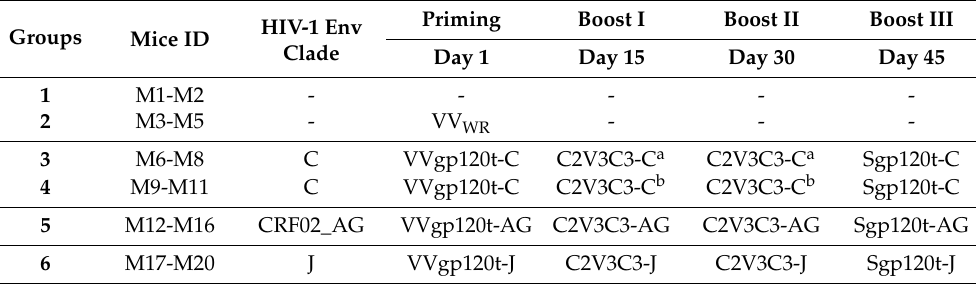
Table 1. BALB / c mice immunization scheme in the pilot